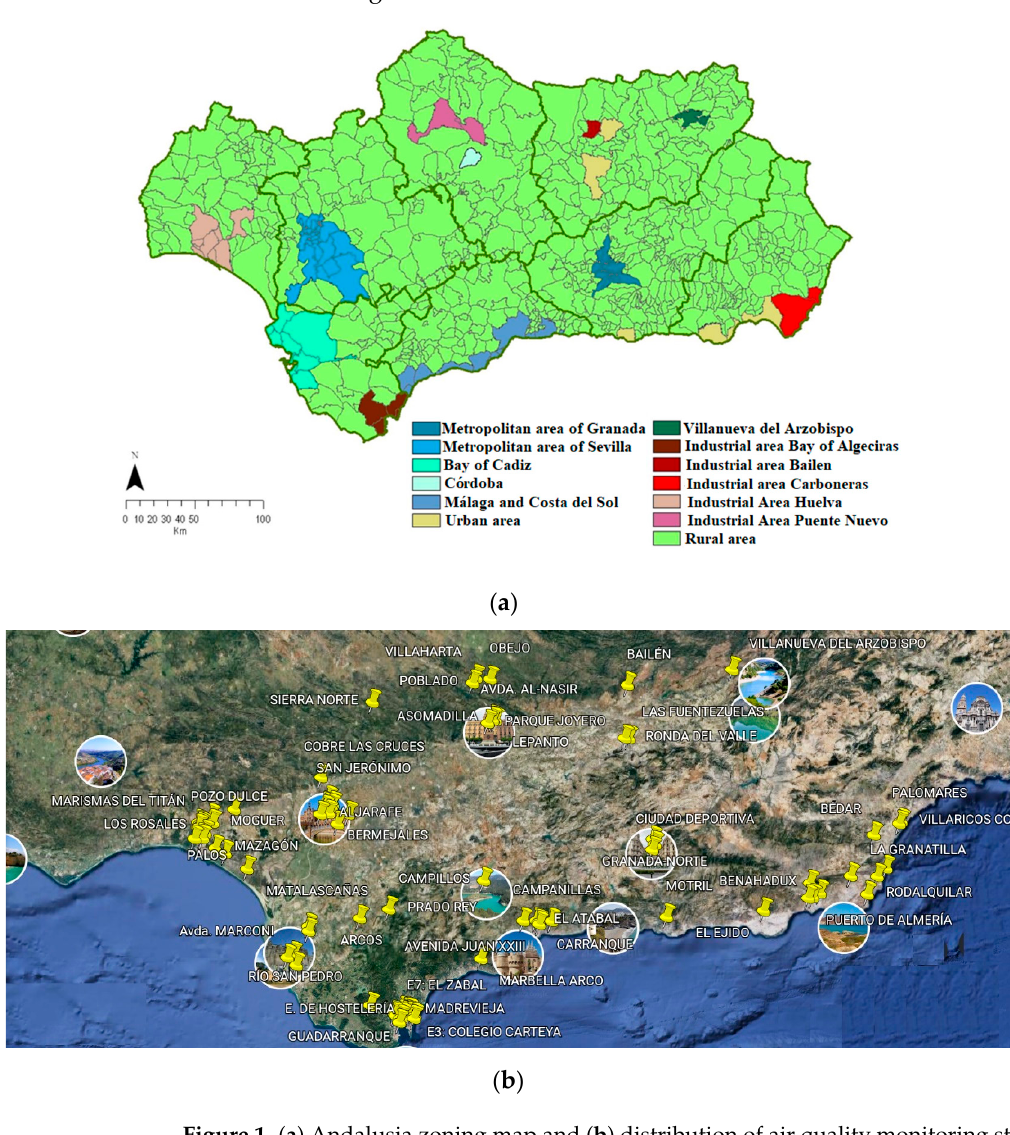
Figure 1. ( a ) Andalusia zoning map and ( b ) distribution of air quality monitoring stations.